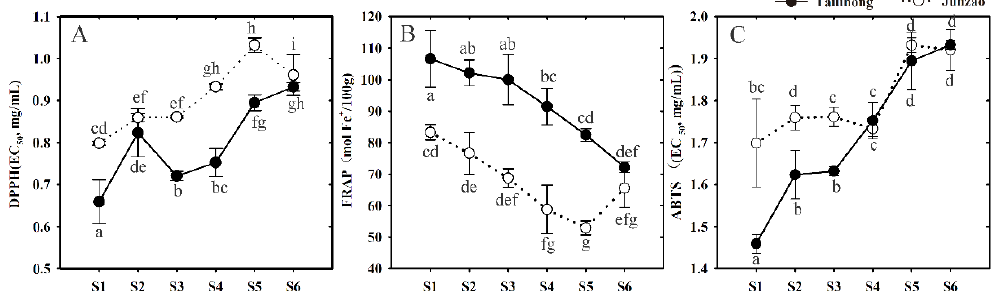
Figure 5. Change of antioxidant activity in the skins of jujube fruit cultivars ‘Tailihong’ and ‘Junzao’ during development. ( A ) DPPH radical scavenging capacity; ( B ) FRAP ferric reducing antioxidant capacity and ( C ) ABTS cation radical scavenging capacity. Different letters (a–g) indicate significant difference at p < 0.05 by Duncan’s test. Developmental stages S1–S6 correspond to days 30, 50, 80, 90, 100 and 110 after anthesis.